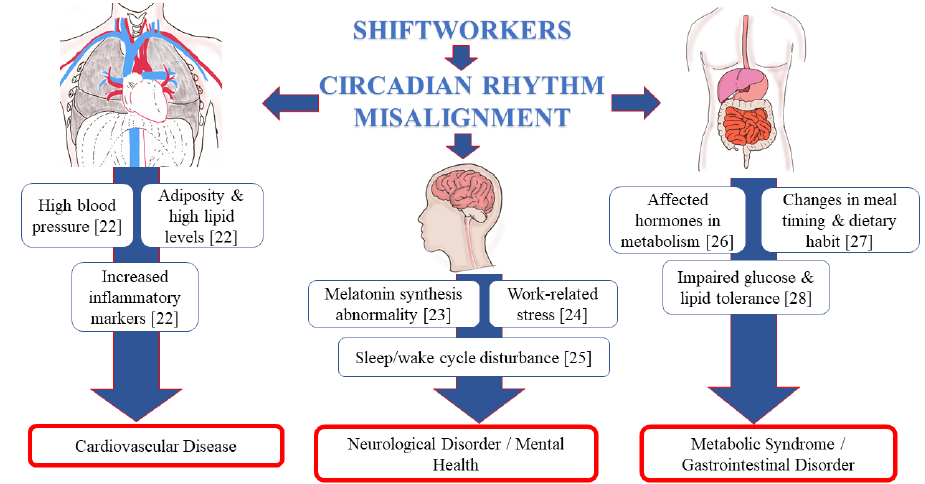
Figure 1. Schematic diagram on the effect of circadian rhythm disruption on different body systems.